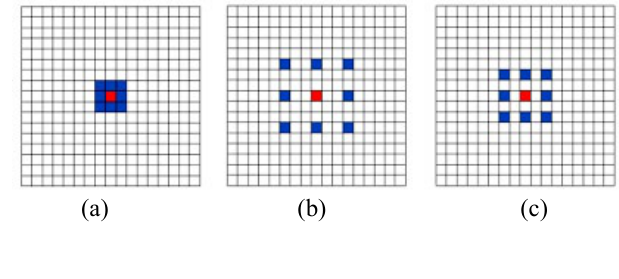
Figure 2. Dilated convolution